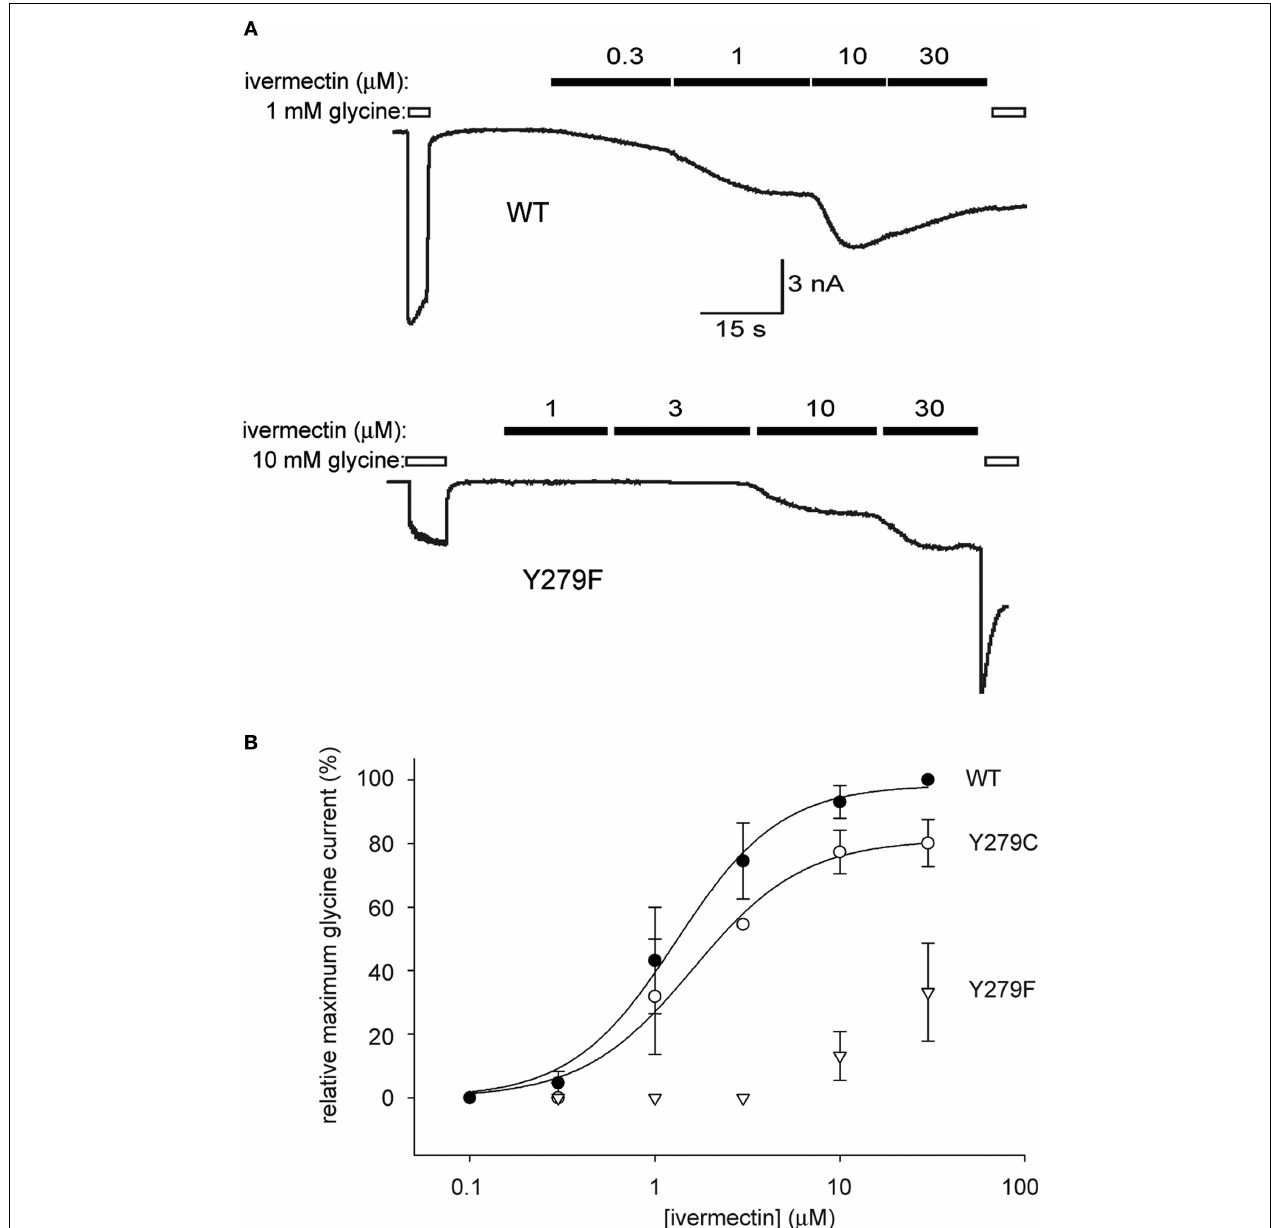
FIGURE 4 | The Y279F mutation dramatically reduces α 1 GlyR sensitivity to ivermectin. (A) Conventional whole-cell patch-clamp recordings from HEK293 cells transiently expressing unmutated or Y279F mutant α 1 GlyRs (upper and lower panels, respectively). The indicated concentrations of glycine and ivermectin were applied as indicated by the unfi lled and fi lled bars, respectively. Because ivermectin activation is irreversible, dose–responses were generated